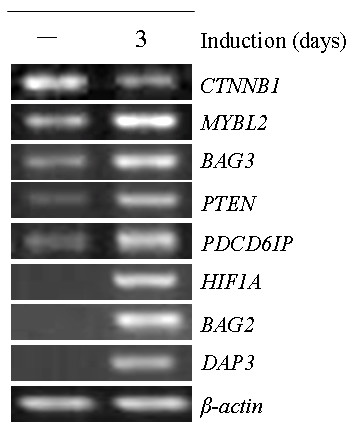
Validation of oligonucleotide microarray results of 8 selected genes by semi-quantitative RT-PCR. HeLaT-β-catenin-RNAi cells were treated with or without DOX for 3 days. RT-PCR was performed as described in Methods. Amplified fragments of CTNNB1, MYBL2, BAG3, PTEN, PDCD6IP, HIF1A, BAG2 and DAP3 genes are indicated. β-actin gene was used as an internal control and was amplified from the same samples.